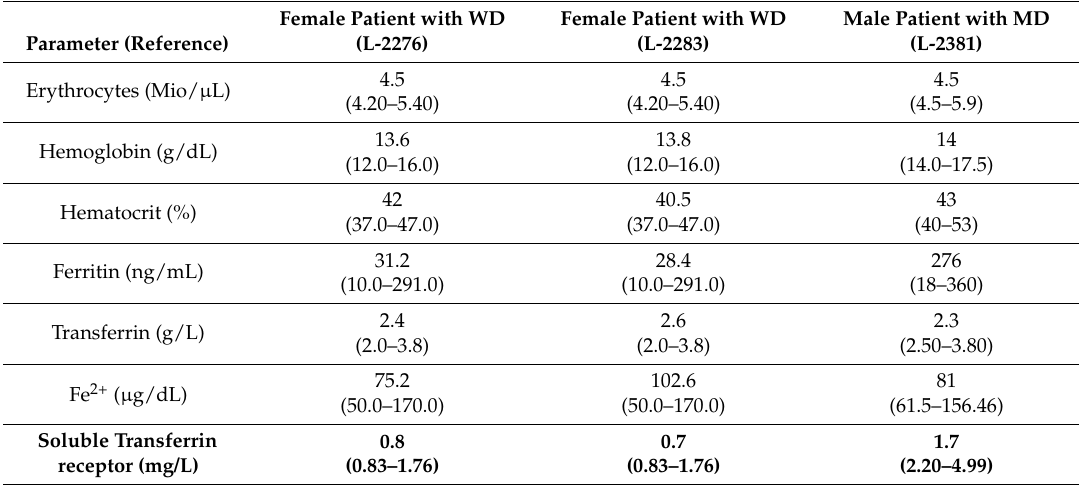
Table 4. Results of blood count for members of Family A with the p.Ile196Val